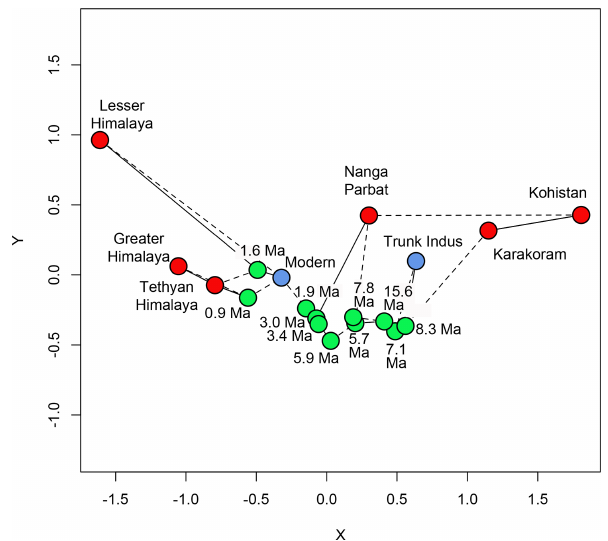
Figure 7. Multidimensional scalar (MDS) plot comparing the detri- tal samples from the Laxmi Basin (green dots) with potential source regions onshore (red dots) and both the modern river mouth and mainstream Indus downstream of Nanga Parbat (blue dots). Data sources are as for Fig. 6. Note progressive migration away from Karakoram–Kohistan end-members and towards the Greater and Tethyan